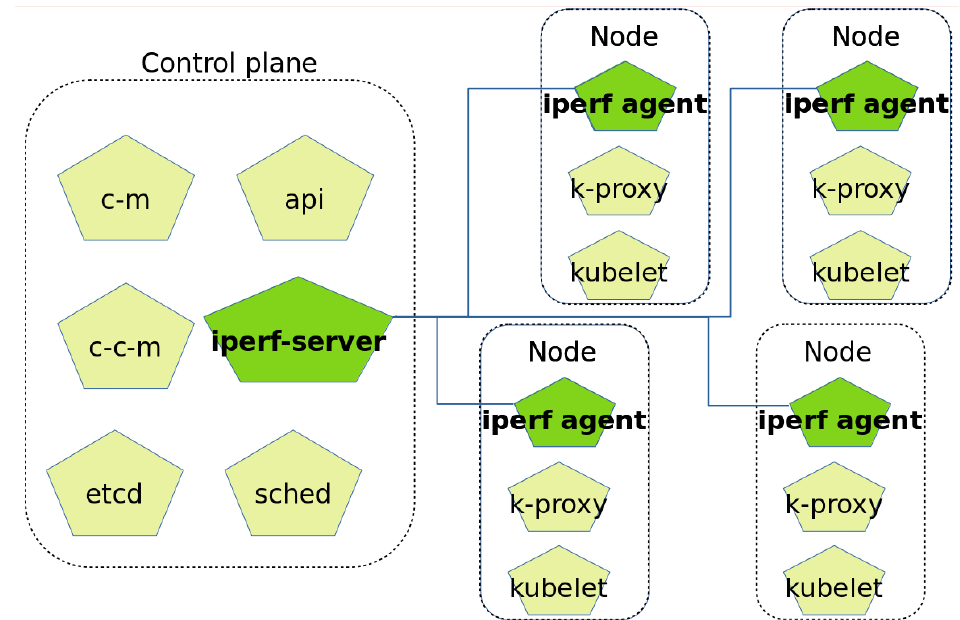
Figure 3. Architecture of a Kubernetes cluster with the